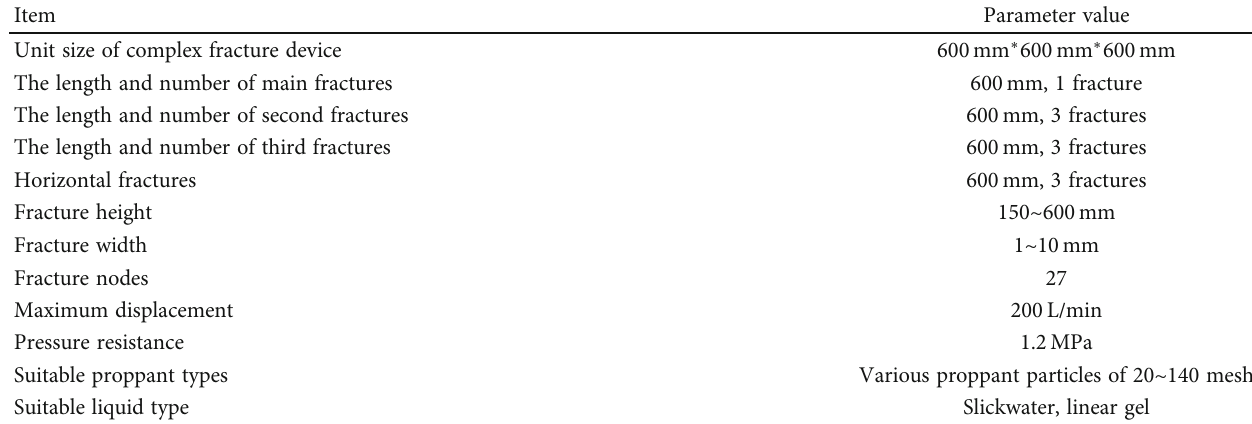
Table 1: Functional parameters of the proppant transport characteristic complex fracture experimental